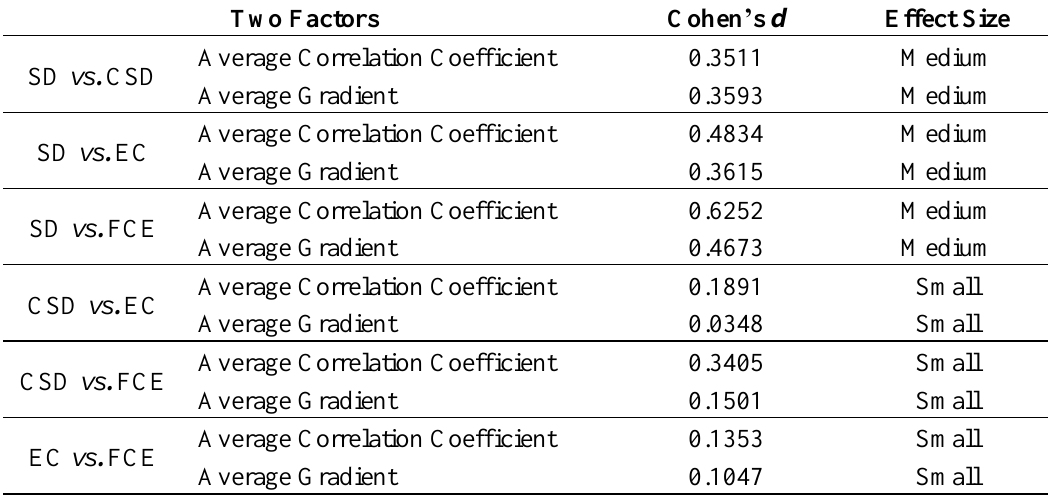
Table 5. The measured Cohen’s d between two factors causing eyestrain with the results of Table 4.